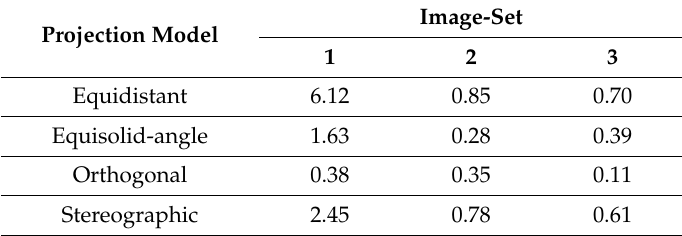
Table 24. RMS-residuals of IOPs